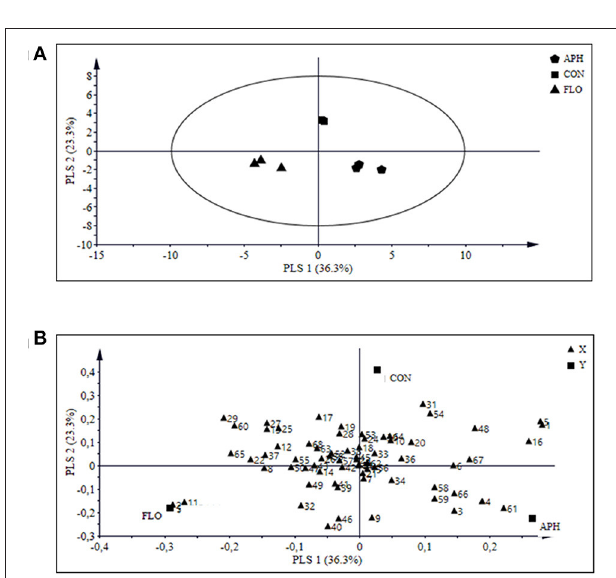
FIGURE 5 | Projection to Latent Structures Discriminant Analysis (PLS-DA) of volatile compounds produced by aphid-infested aubergine plants ( n = 3, APH), flowering aubergine plants ( n = 3, FLO) or uninfested plants ( n = 3, CON). The score plot (A) visualizes the structure of the samples according to the first two PLS components with explained variance in brackets. The ellipse defines Hotelling’s T 2 confidence region (95%). The loading plot (B) defines the orientation of the PLS panels with the original variables in the X (volatile variables) and Y space (class variables: APH, FLO, and CON). For number interpretation of the volatiles please refer to Table 2